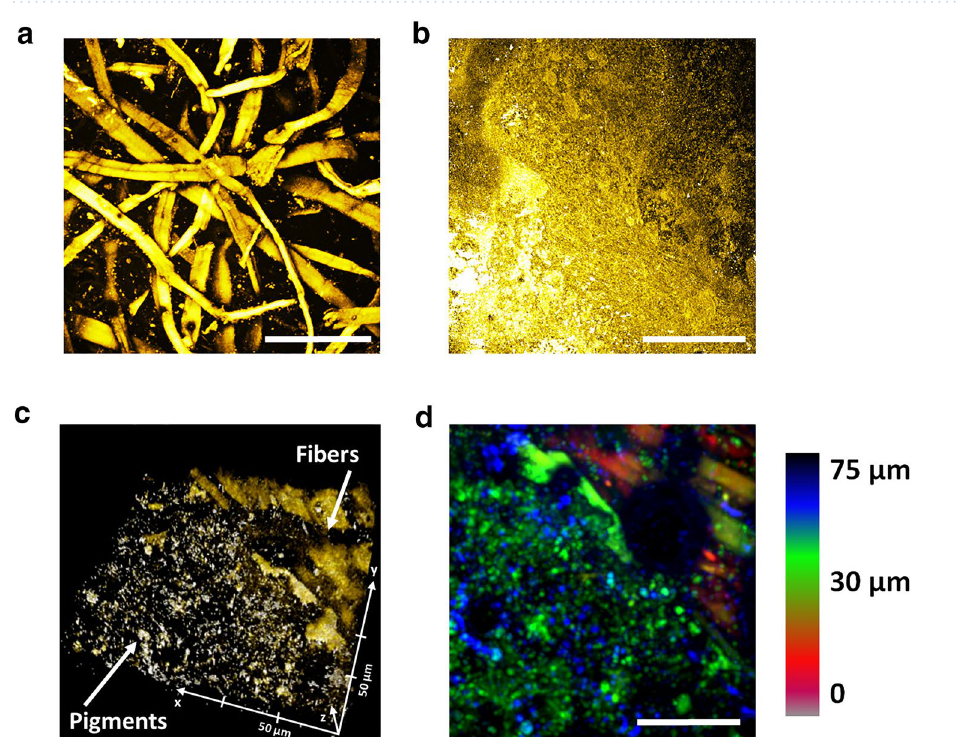
Figure 5. Fluorescence microscopy of Kinkarakawa-gami wallpapers. CLSM imaging of representative portions of INV_15 on both verso and recto are illustrated in ( A , B ) respectively, while ( C ) depicts a representation of the 3D reconstruction performed on INV_15 recto, whose multilayer structure is quantitatively reported in depth- colour code (analysis depth 75 µm) in ( D ). Scale bars are 100